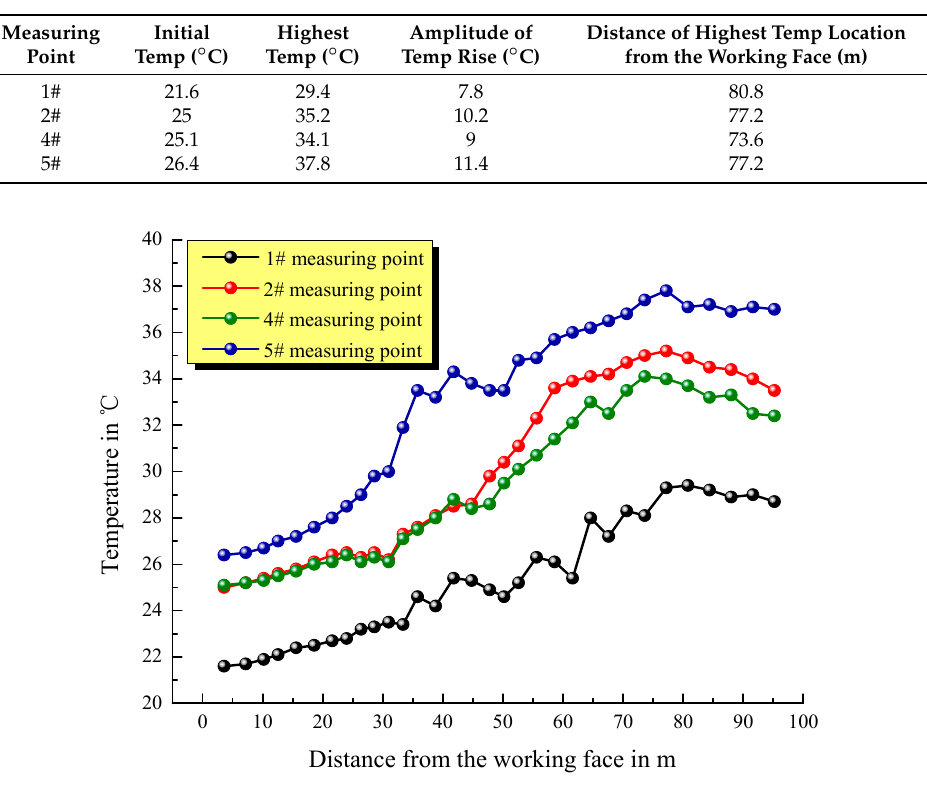
Table 6. Overview of the temperature distribution in the goaf.